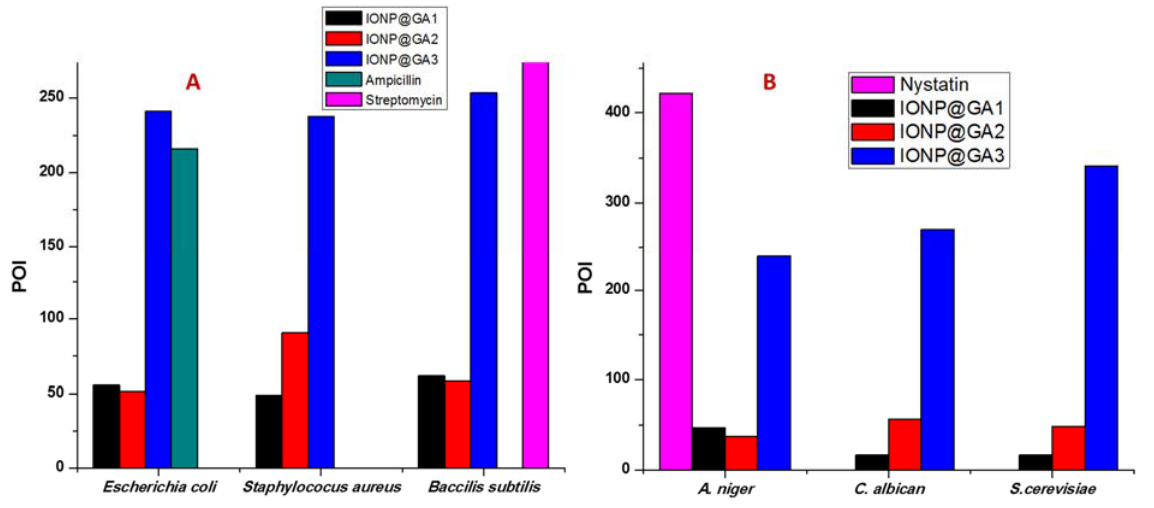
Figure 9. Percentage of inhibition (POI) of ( A ) bacterial growth and ( B ) mycelia growth of fungi, after treatment with